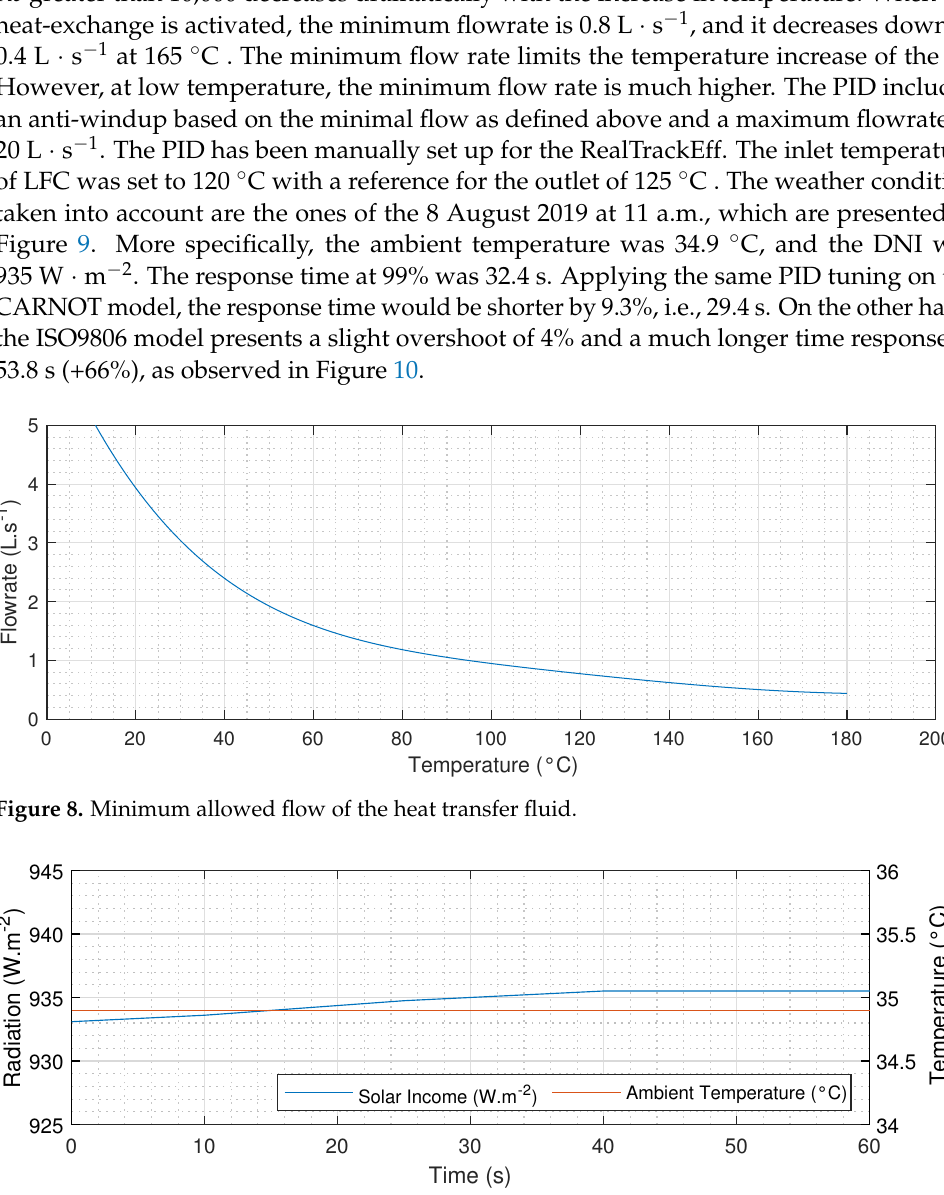
Figure 9. Weather data on the 8 August 2019 for the PID